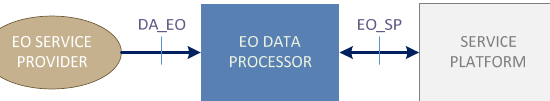
Figure 2. The EO Data Processor within the PHAROS